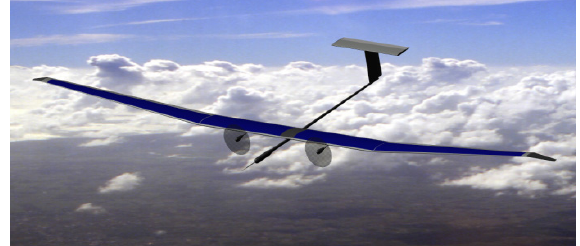
Figure 1. The solar-powered aircraft.